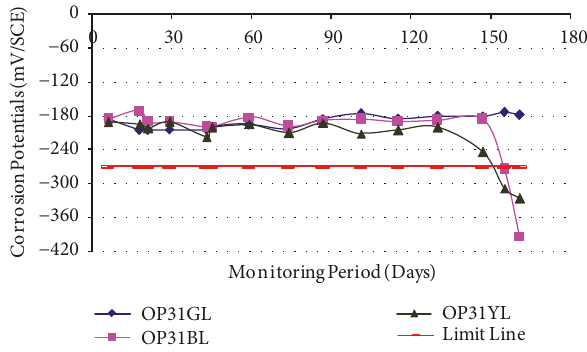
Figure 7: Corrosion potential versus time for OPC at w/c of 0.80.